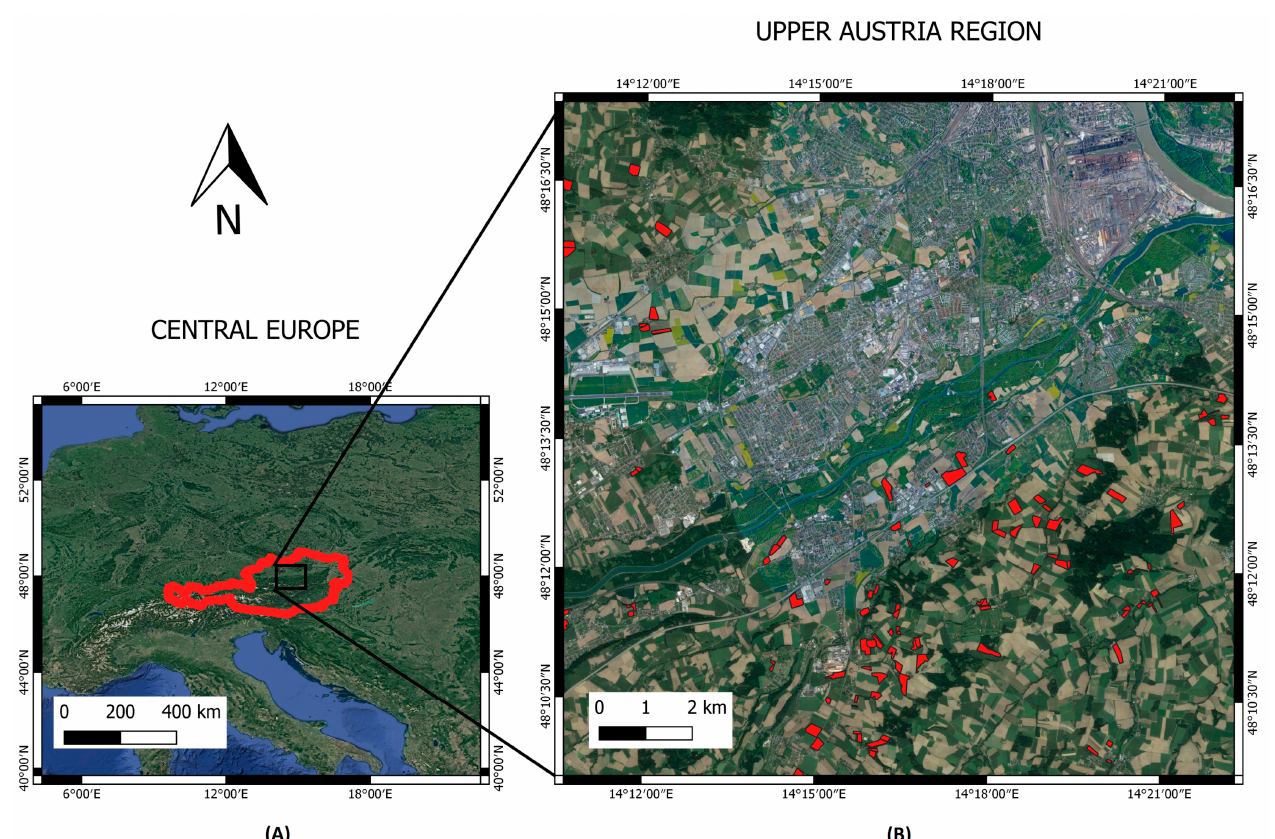
Figure 2. Location of the fields from the dataset. ( A ) The selected study region in the Upper Austria denoted by the black box. ( B ) Spatial distribution of fields within the study